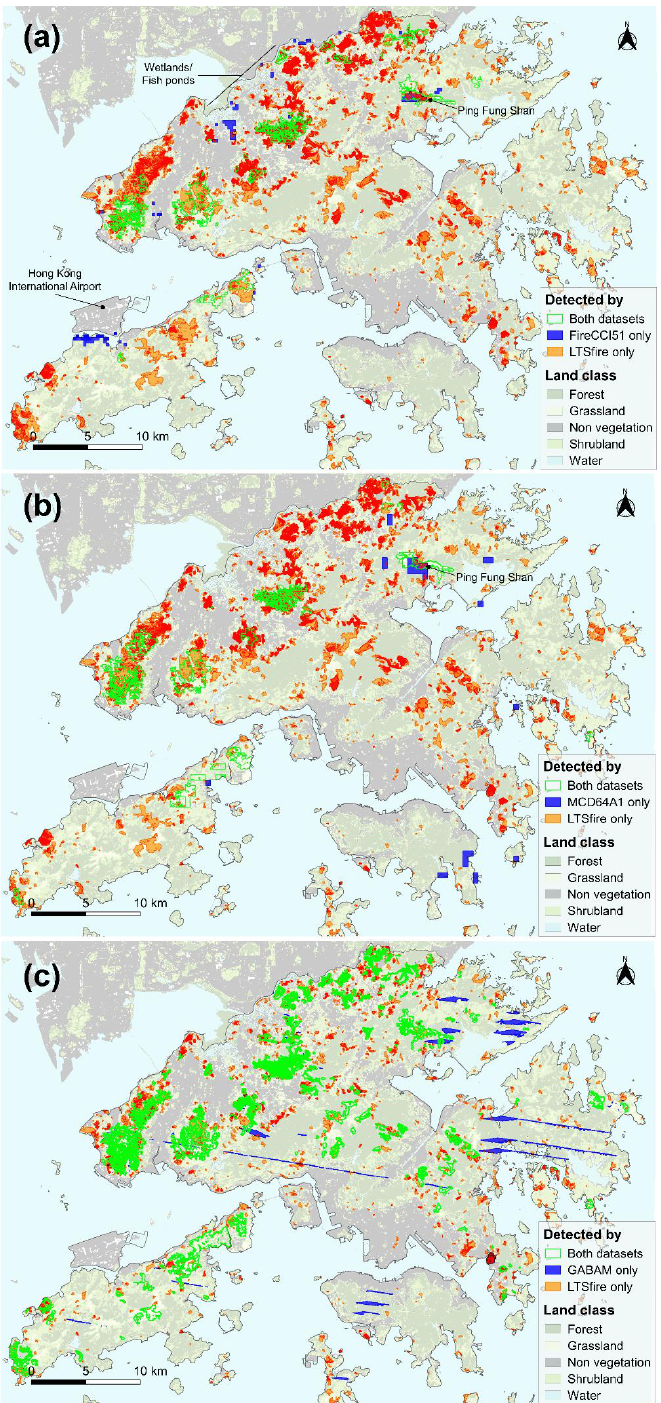
Figure 8. Comparing the burn area map produced in this study (LTSfire) with three existing global BA products, ( a ) FireCCI51, ( b ) MCD64A1, and ( c ) GABAM. Areas delineated by the green polygons corresponds to the areas where LTSfire agrees with the existing dataset (Denoted by Ai ∩ Bi, or grey shading, in Figure S1). Polygons with blue or orange fill represent burnt patches only detected by the existing (Bd in Figure S1) or LTSfire (Ad in Figure S1) map, respectively. Darker shades of orange represent repeated fires in the same area omitted by the existing dataset. A 2013–2014 land classification map of Hong Kong (22 ◦ 16 (cid:48) 8 (cid:48)(cid:48) N, 113 ◦ 57 (cid:48) 6 (cid:48)(cid:48) E) derived from the Landsat data is shown in the background (Chan et al. unpublished